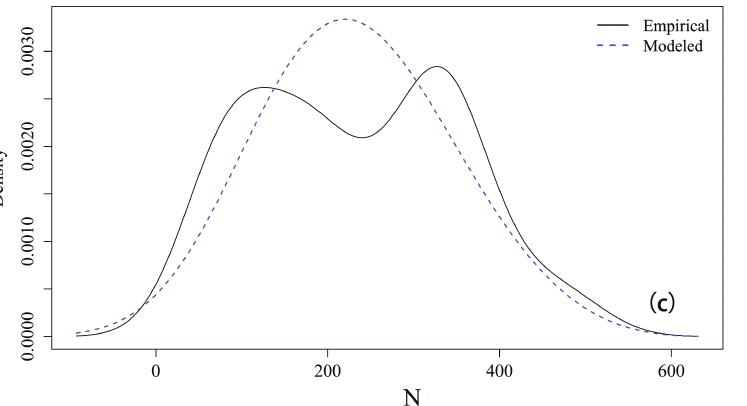
Figure 3. Three diagnostic plots fitting the GEV to the maximum values at a daily scale. ( a ) The QQ-plot compares the empirical data quantiles and the GEV fit quantiles. ( b ) The QQ-plot shows the randomly generated data, which is from the fitted GEV, against the empirical data quantiles, and the 95% confidence bands (black dashed line) of the QQ-plot get close to be linear. ( c ) The plot shows that the empirical density of the observed maximum (black solid line) against GEV fit density (blue dashed line).